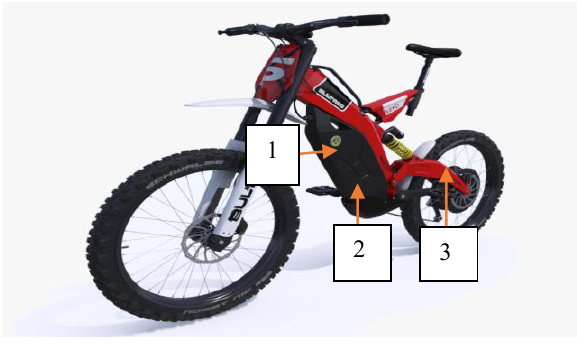
Fig. 1. An electric bicycle consisting of: 1 - battery, 2 - controller, 3 - engine [2] The work assumes that the bike will be powered by a 3000 W motor at 48 V power supply. It is a relatively high power that allows you to get satisfactory results while driving. The brushless motor is chosen for quiet